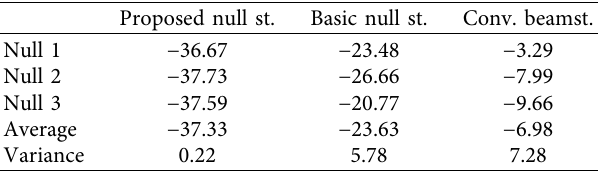
Table 5: Null depth values (in dB) as obtained from the simulation results entailing the proposed and basic null steering mechanisms. Proposed null st.